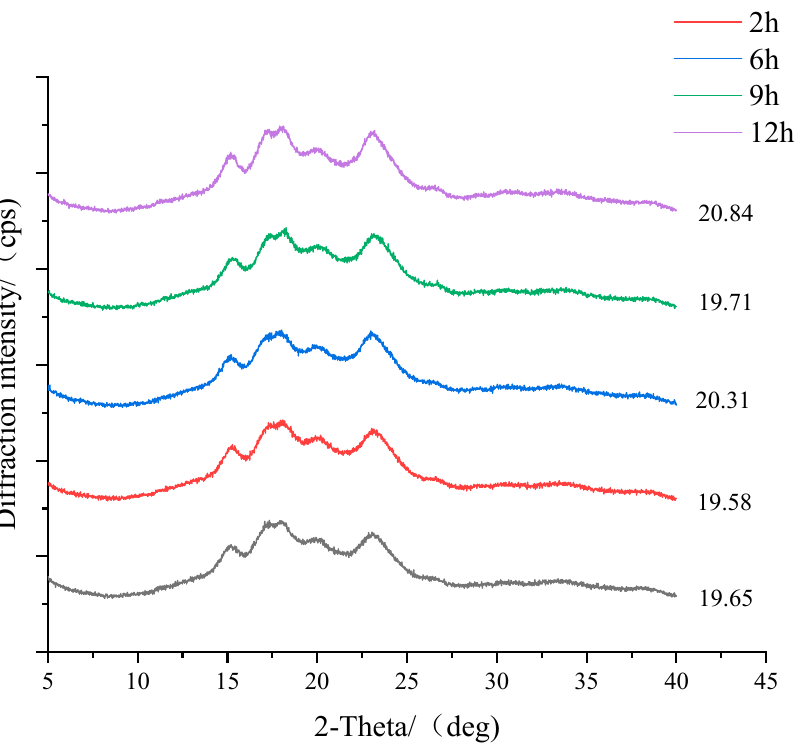
Figure 4. X-ray diffraction patterns for starch samples separated from bifidobacteria-fermented Figure 4. X ‐ ray diffraction patterns for starch samples separated from bifidobacteria ‐ fermented dough at different fermentation dough at different fermentation times.